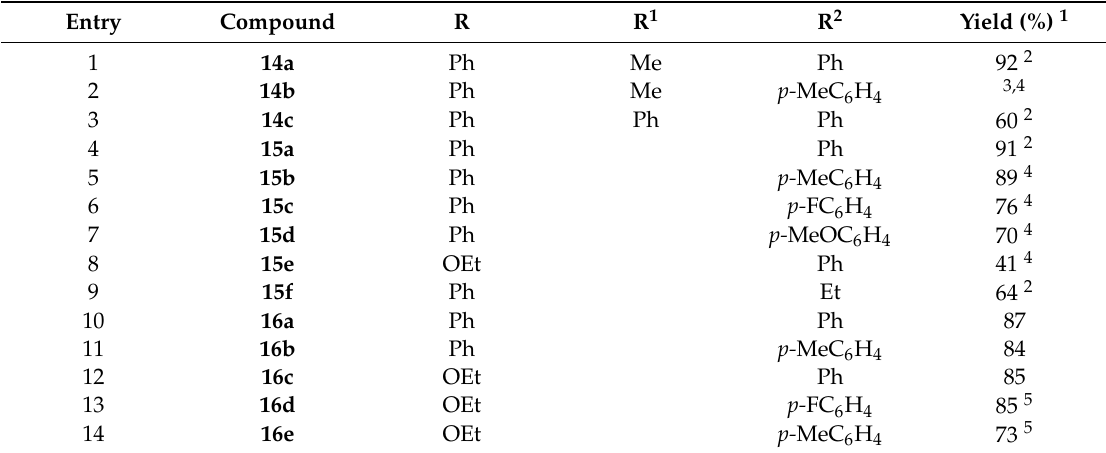
Table 3. Aziridines 14 and allylic α -aminophosphine oxides and phosphonates 15 and 16